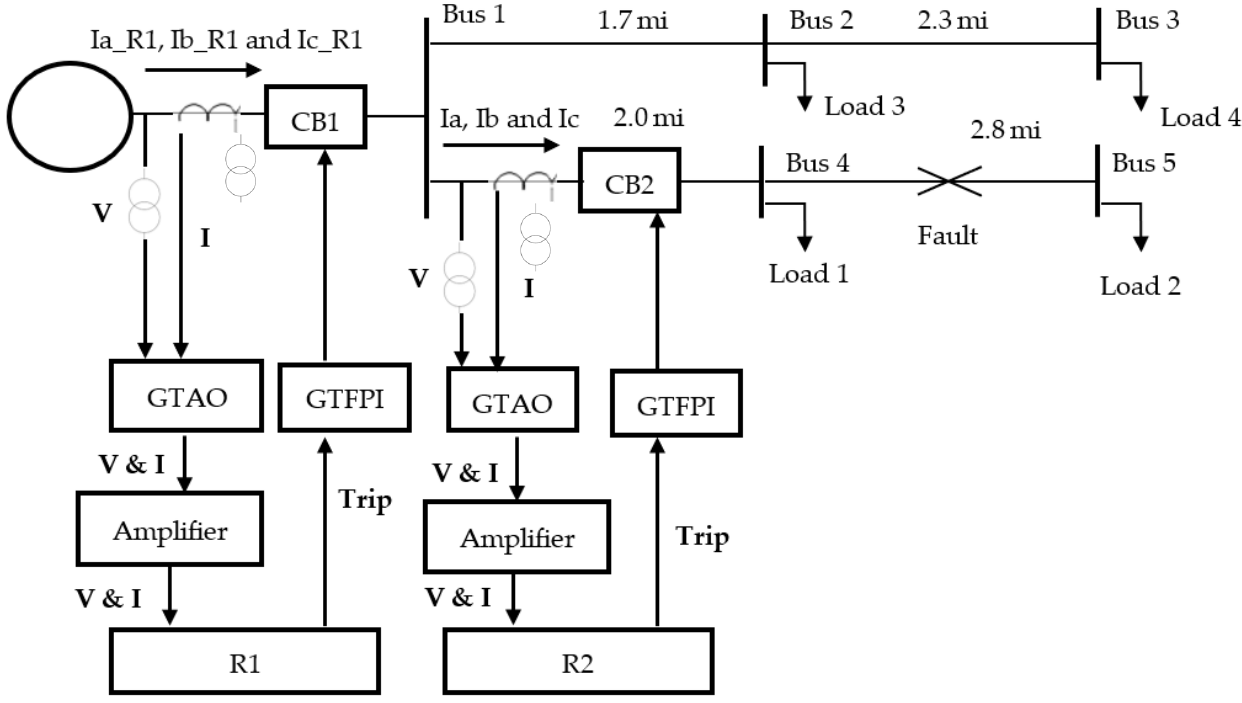
Figure 9. Block diagram for HIL